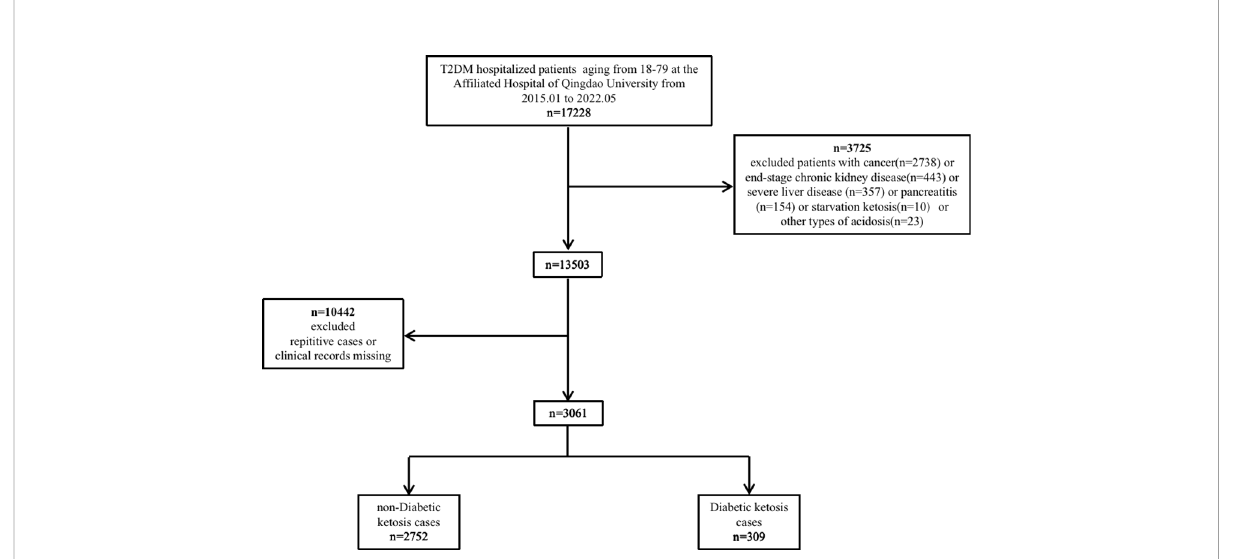
FIGURE 1 Flowchart of the inclusion and exclusion of